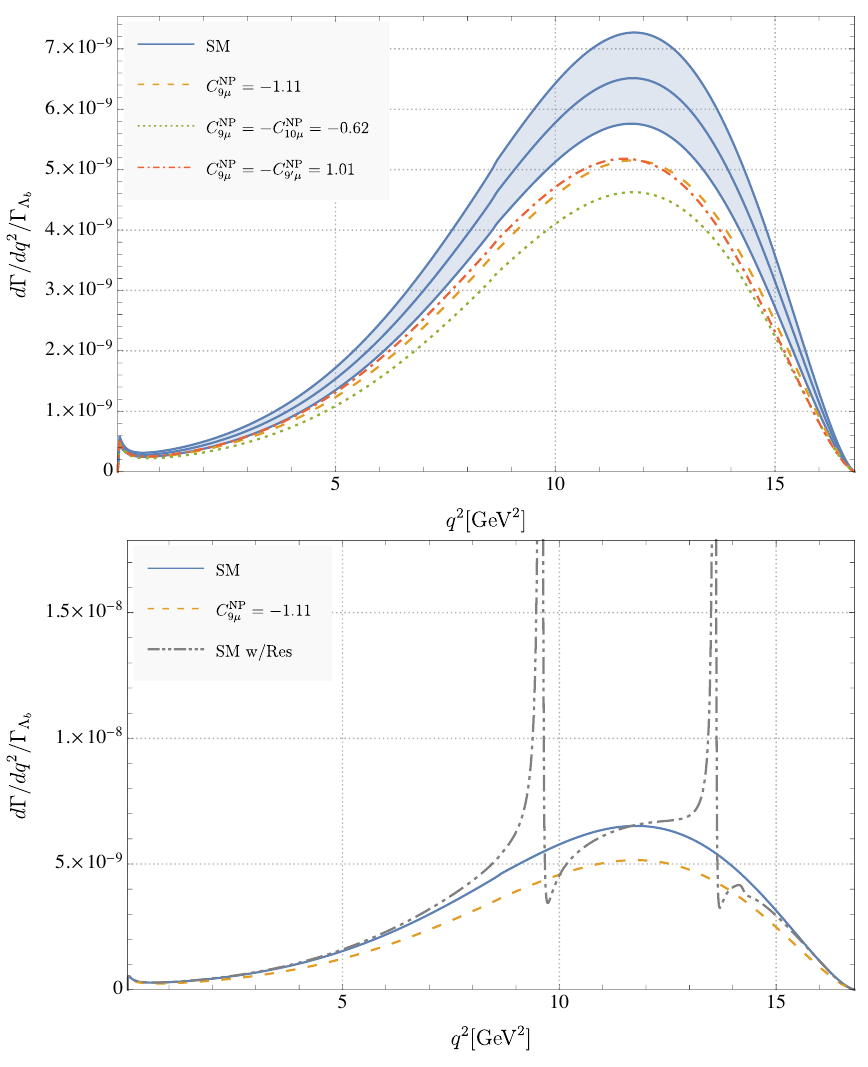
Figure 1 . Top: Di(cid:11)erential decay rate (normalised to the total (cid:3) b decay width) in the SM case and three NP scenarios. Only short-distance contributions from charm loops are include. Bottom: For illustration only, we also show the e(cid:11)ect of a model for charmonium resonances in the SM case